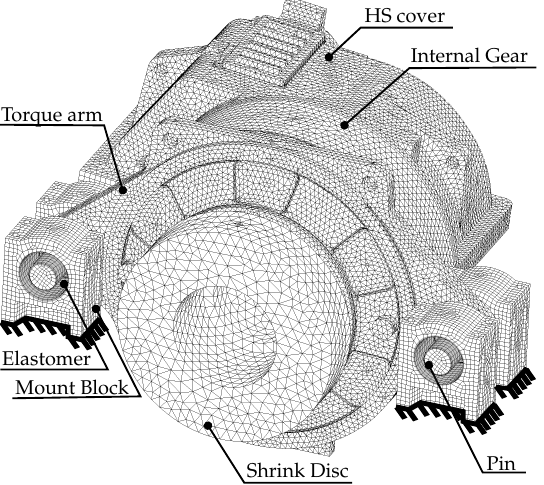
Figure 10. Overview on the finite element model of the gearbox housing and supporting components.